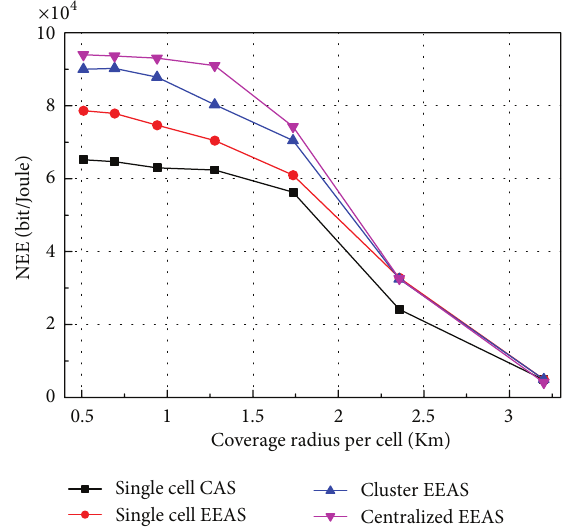
Figure 2: NEE versus Coverage radius per cell with 𝑁 max = 4, 𝑃 = 20 W, and 10 users per